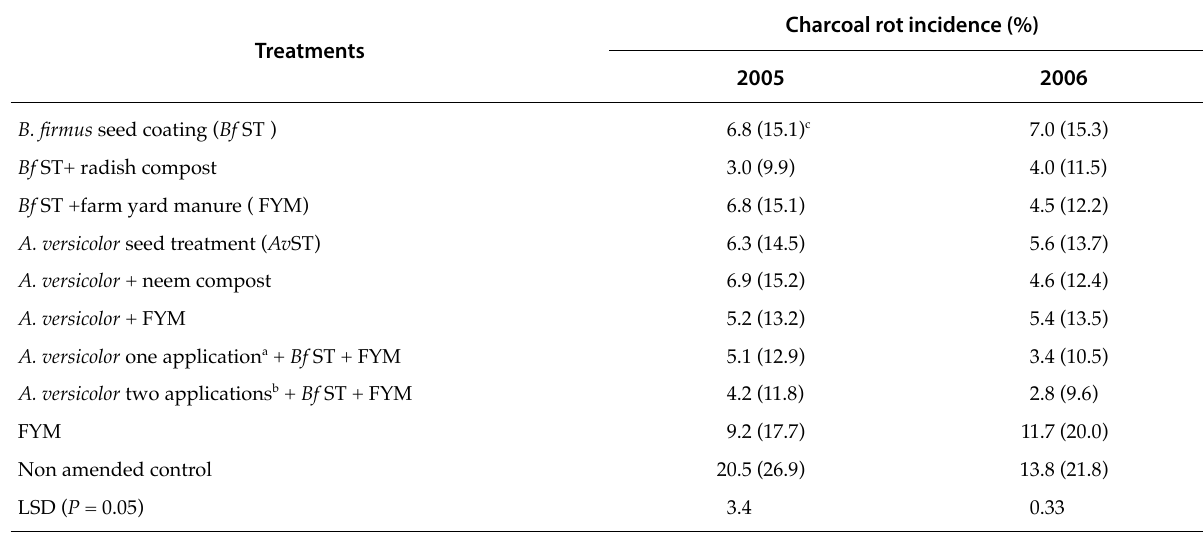
Table 1. Mean incidence of cowpea charcoal rot in two growing seasons, from treatments with the biocontrol agents Bacillus firmus and Aspergillus versicolor in different soil amendments..